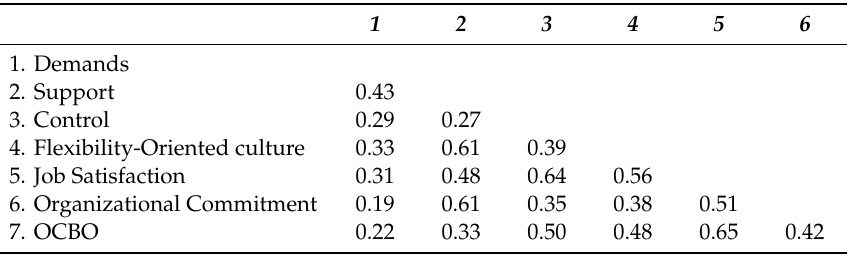
Table 4. Outer model: Discriminant validity results following